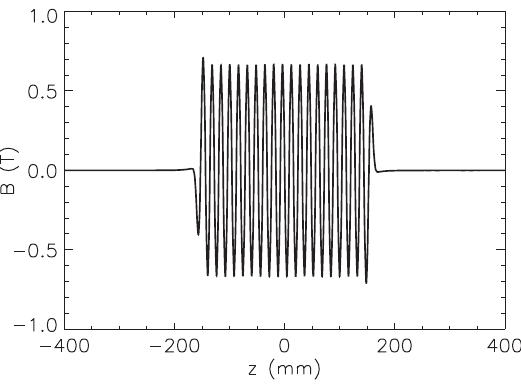
FIG. 8. Helium liquefaction using excess refrigeration capacity.